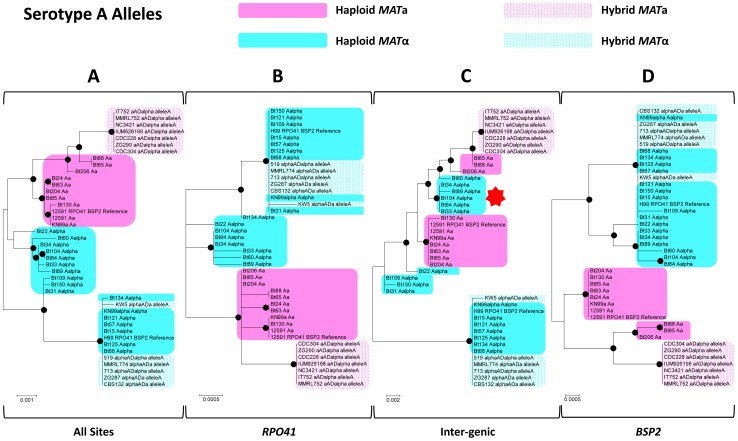
Phylogenetic trees of serotype A alleles existing in natural C. neoformans isolates based on the sequenced RPO41-intergenic-BSP2 region.Phylogenetic trees based on whole sequences (A), sequences corresponding to the RPO41 gene (B), the intergenic regions (C), and the BSP2 gene (D) were constructed using the maximum likelihood method with 1000 bootstrap replications. Black dots indicate the nodes supported by bootstrap values of 75 or higher. Solid and dotted pink shades highlight MAT
a alleles from haploid and hybrid isolates, respectively. Solid and dotted blue shades highlight MATα alleles from haploid and hybrid isolates, respectively. The red star in section (C) highlights the group of haploid MATα alleles that clustered together with MAT
a alleles.